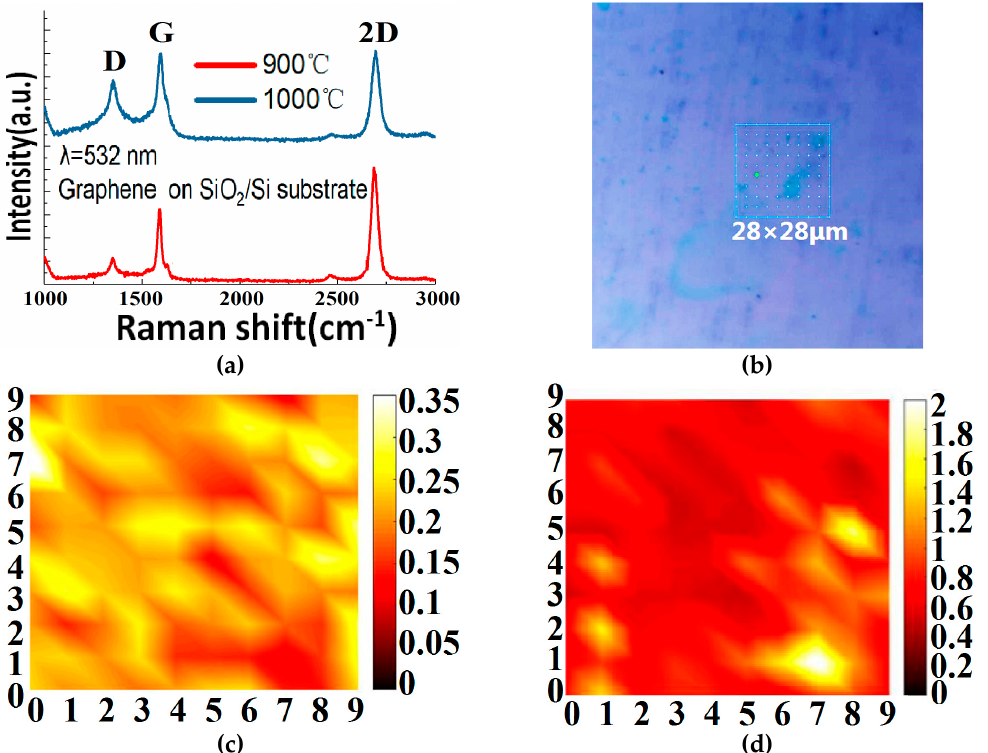
Figure 6. ( a ) Raman spectra of the graphene prepared by the GD method at 900 °C and 1000 °C by using copper foil as a catalyst. ( b ) Optical image (taken by Raman microscope) of a graphene thin film grown on copper foil at 900 °C and transferred to its SiO 2 /Si substrate. The 28 μ m × 28 μ m part indicated by the square is the area for Raman mapping. ( c , d ) Raman mapping (28 μ m × 28 μ m) of the D/G and G/2D ratios of the graphene grown on copper foil at 900 °C and transferred to its SiO 2 /Si substrate. In each image, there are 10 × 10 measured points and the color bar indicates the ratio.